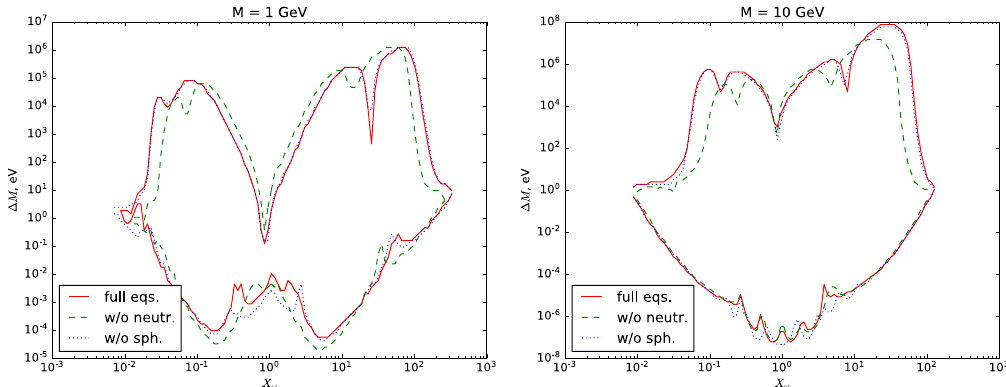
Figure 6 . Comparing the kinetic equations with accurate susceptibilities and accurate treatment of sphalerons (red curve), with diagonal susceptibilities (no plasma neutrality) (green dashed curve) and with the instantaneous freeze-out of sphalerons (blue dotted curve). The same choice of phases as in the previous figure. Left panel , common mass M = 1 GeV. Right panel , common mass M = 10